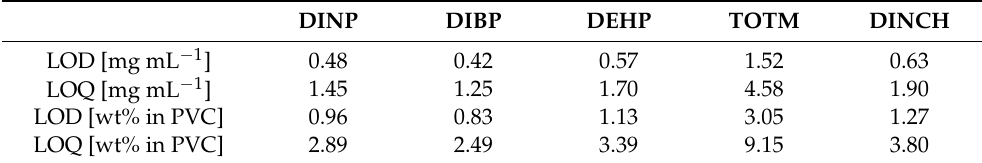
Table 1. Detection and quantification limits of examined plasticizers dissolved in non-deuterated n- hexane and measured at 40 MHz within 1 min. Both limits are given in concentrations for the analyzed solution and in amounts a PVC material would need to contain to achieve these concentrations after a solvent extraction. The aromatic peaks’ integral was used to determine detection and quantification limits for all plasticizers except DINCH, where the ester peaks’ prominence at 3.5 ppm was selected. DINP DIBP DEHP TOTM LOD [mg mL − 1 ] LOQ [mg mL − 1 ] LOD [wt% in PVC] LOQ [wt% in